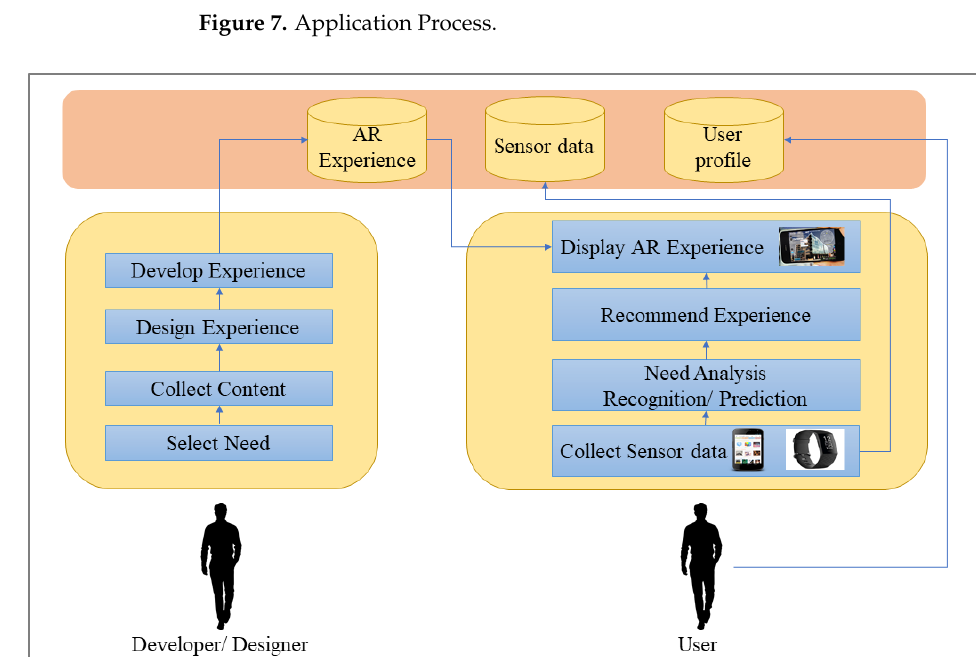
Figure 8. Testing prototype architecture.